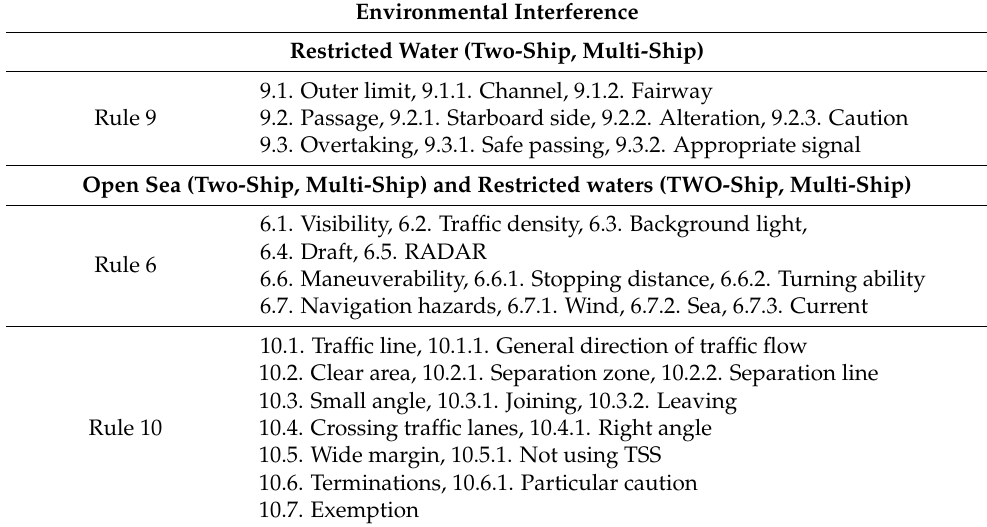
Table 4. Requirements analysis for environmental interference.